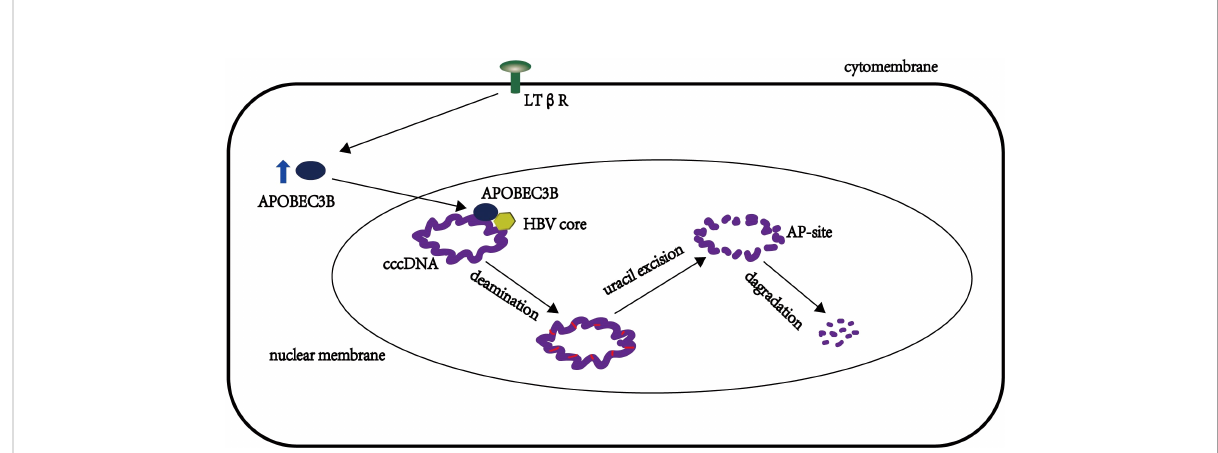
FIGURE 2 APOBEC3B-induced molecular mechanism model of degradation of HBV